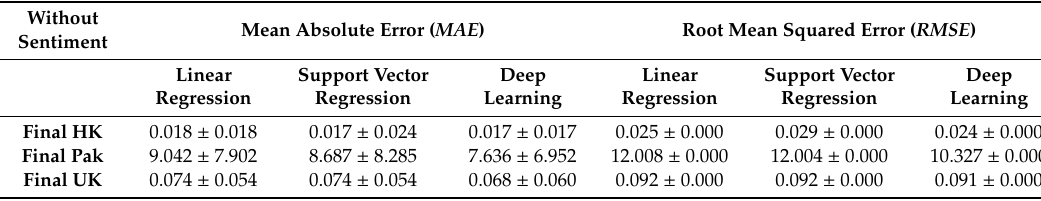
Figure 3. The plot of 50 forecasted and actual values of the foreign exchange rate of Hong Kong, Pakistan, and the UK considering linear, support vector, and deep learning model (without sentiment). LR: Linear regression, SVR: Support vector regression, DL: Deep learning. Table 5. Results for all the countries without event sentiments.